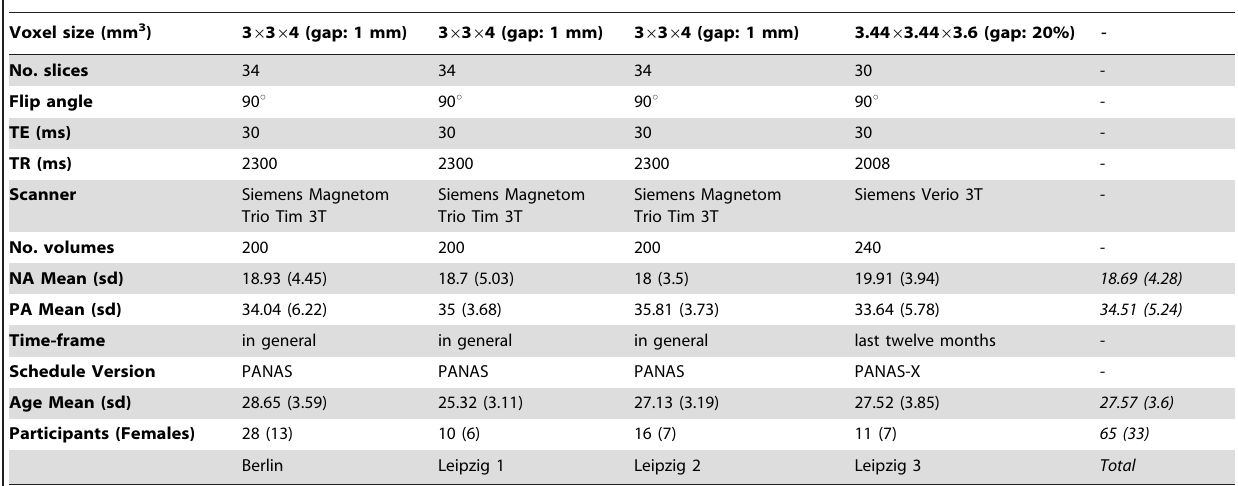
Table 1. Participant details and acquisition parameters.